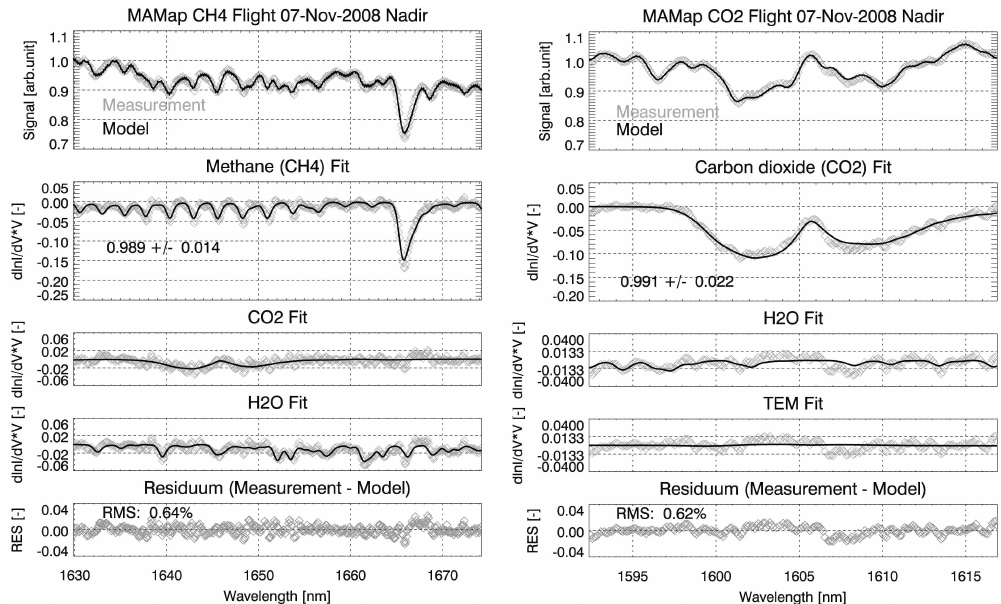
Fig. 5. WFM-DOAS fits in the spectral regions used for CH 4 (left) and CO 2 (right) retrieval. The MAMAP spectral measurements have been made on 7 November 2008 during the flight from Oshawa to Wilmington, USA, on board of the Polar-5 aircraft of the Alfred-Wegener- Institute (AWI), Bremerhaven, Germany. Left: The top panel shows a MAMAP nadir spectrum (grey symbols) and the solid line the fitted linearized radiative transfer model. The bottom panel shows the fit residuum, which is the difference between measurement and simulation after the fit (the root-mean-square, RMS, of the fit residuum, RES, is 0.64%). The second panel shows details of the methane fit. The solid line is the scaled derivative of the radiance with respect to a change of the methane vertical column. The retrieved scaling factor for the methane vertical profile is 0.989 ± 0.014, i.e., the retrieved columns is 1.1% lower than the vertical column which has been assumed for the radiative transfer simulations. The grey symbols show the “methane fit residuum”, which is identical with the black curve except that the spectral fit residuum has been added. The third and the fourth panel show the corresponding results for the interfering gases CO 2 and H 2 O. Right: similar as left figure but for the CO 2 fitting